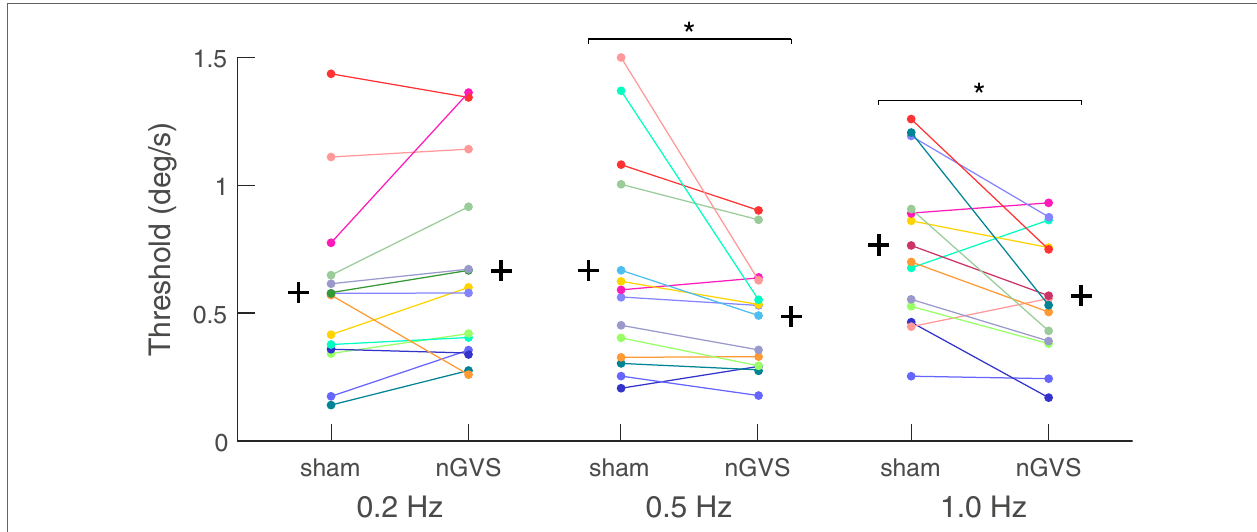
FigUre 2 | Motion recognition thresholds for the sham and noisy galvanic vestibular stimulation (nGVS) conditions for individual subjects: a significant nGVS- induced reduction in motion recognition thresholds was found at 0.5 and 1.0 Hz. nGVS did not affect motion recognition thresholds at 0.2 Hz. The ( + ) sign represents the group mean of each condition tested.